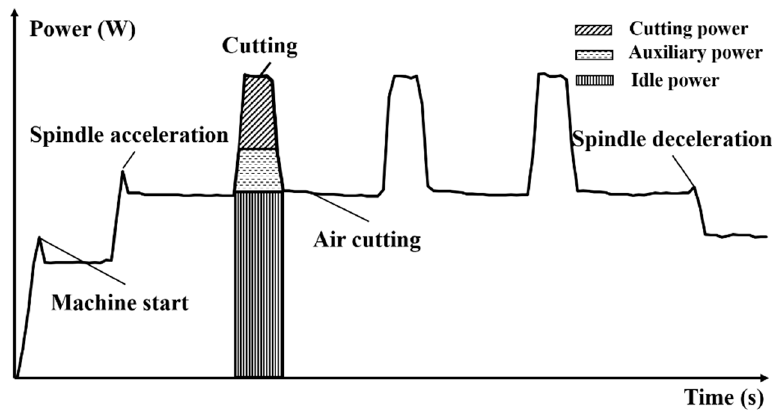
Figure 1. The power profile in a drilling process.